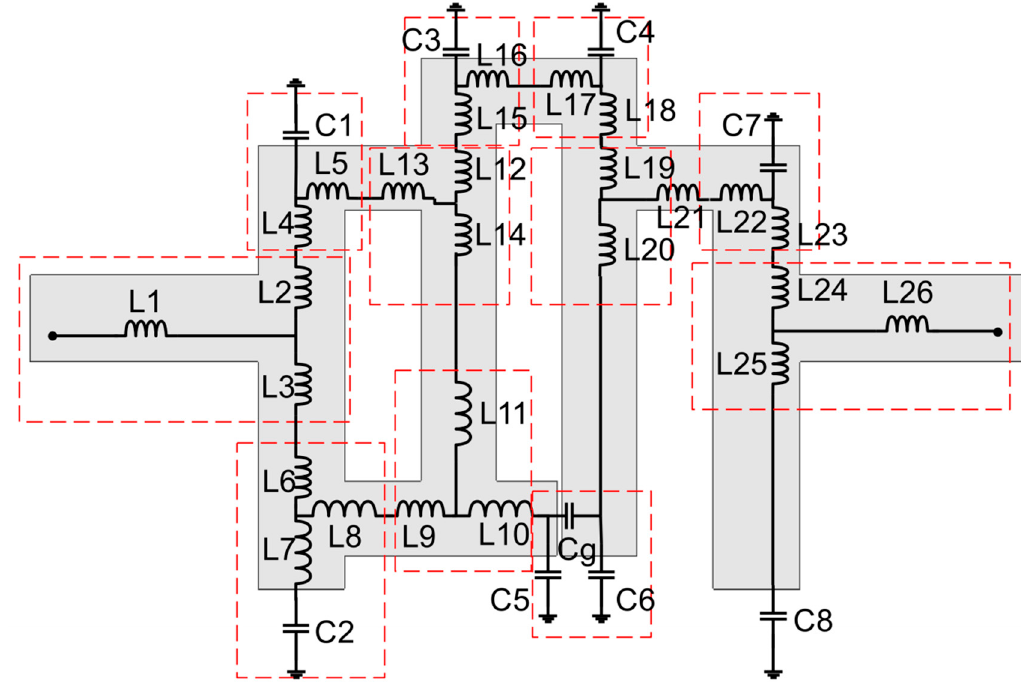
Figure 9. Equivalent circuit when PIN diode is ON (mode 1).